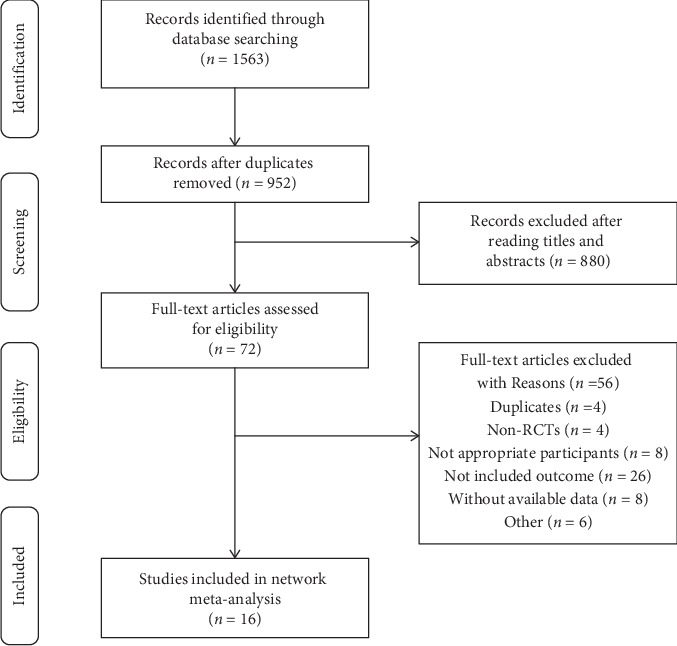
PRISMA flowchart.